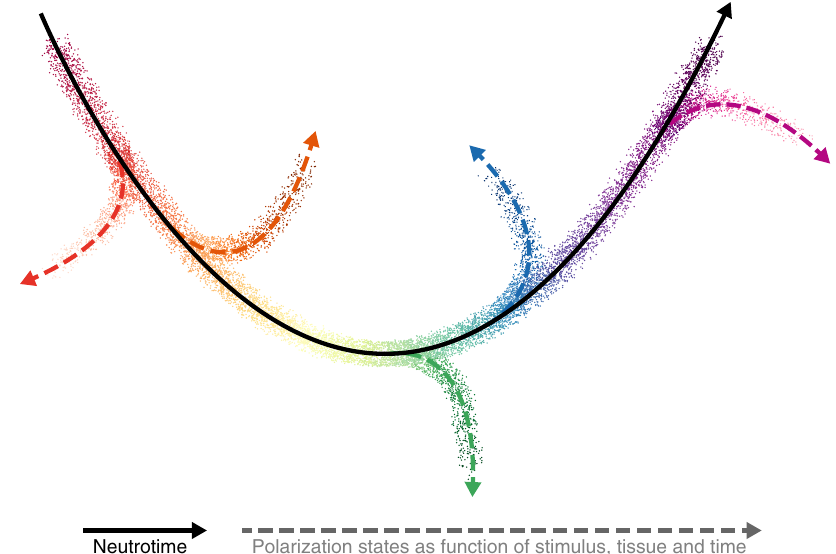
Fig. 9 Proposed working model: neutrotime as the central organizing principle of neutrophil heterogeneity. Healthy neutrophils are organized along one main sequence, termed neutrotime, from which they deviate as a function of time and environmental cues to reach different polarization states, orchestrated by shared and context-speci fi c transcription factors. Experimental in fl ammation was found to recruit neutrophils predominantly near the mature pole of neutrotime; however, deviation from points earlier in the spectrum is also likely, re fl ected in arrows all along the neutrotime continuum. The colors of cells polarizing into different states illustrate that some features of the neutrotime sequence are